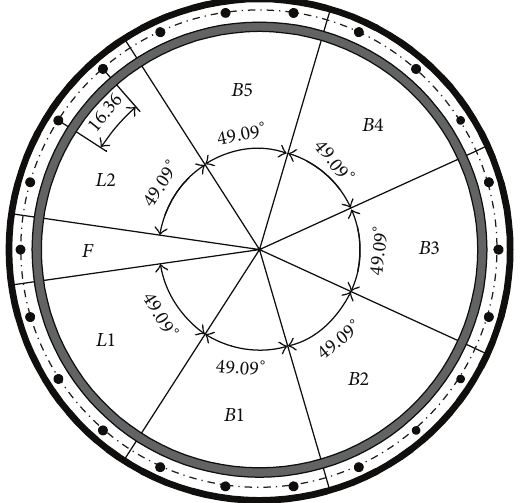
Figure 6: Double lining of Shiziyang Tunnel.